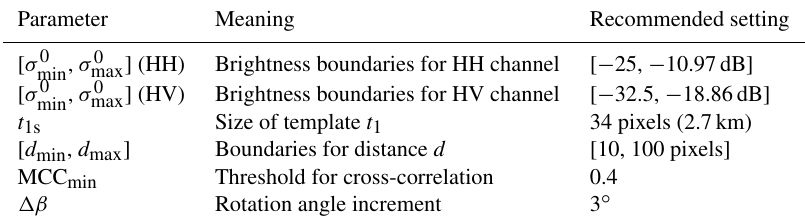
Threshold for cross-correlation 0.4 (cid:49)β Rotation angle increment 3